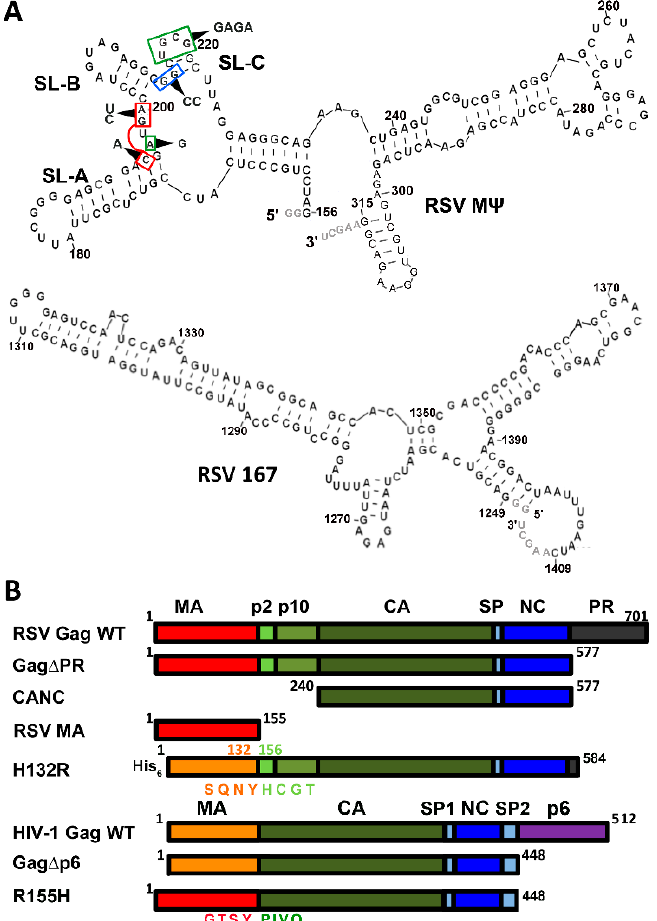
Figure 1. Rous sarcoma virus (RSV) RNA, and RSV and human immunodeficiency virus type 1 (HIV-1) protein constructs used in this work. ( A ) Predicted secondary structures of RSV M Ψ ( top ) and RSV 167 ( bottom ) derived from nucleotides (nt) 156–315 and 1249–1409 of the RSV Prague C genome, respectively. Four mutant M Ψ constructs are indicated by the boxed nt and arrows: UGCG to GAGA, GG to CC, A197G, and a triple mutation AGC to UCA. Additional nt at the 5 (cid:48) and 3 (cid:48) ends of each RNA that are not present in the RSV genome are shown in gray; ( B ) RSV and HIV-1 Gag constructs used in this work, with full-length wild-type Gag shown at the top of each set for comparison. Matrix (MA), capsid (CA) and nucleocapsid (NC), as well as various spacer peptides (SP, SP1, and SP2), the HIV-1 p6 domain, and the RSV p2, p10, and protease domain (PR) comprise these constructs. In the case of the two chimeric constructs, H132R and R155H, the residues at the junctions are explicitly shown. H132R contains the 132-residue HIV-1 MA in place of RSV MA in the context of RSV Gag, and R155H contains the 155-residue RSV MA in place of HIV-1 MA in the context of HIV-1 Gag. Although the minimal element that is both necessary and sufficient to confer selective HIV-1 gRNA packaging is not yet known, a gRNA packaging competition assay has defined a “core encapsidation signal” composed of the U5 region and stem-loops 1–4 (SL1–SL4) of Ψ [7]. In the absence of Ψ